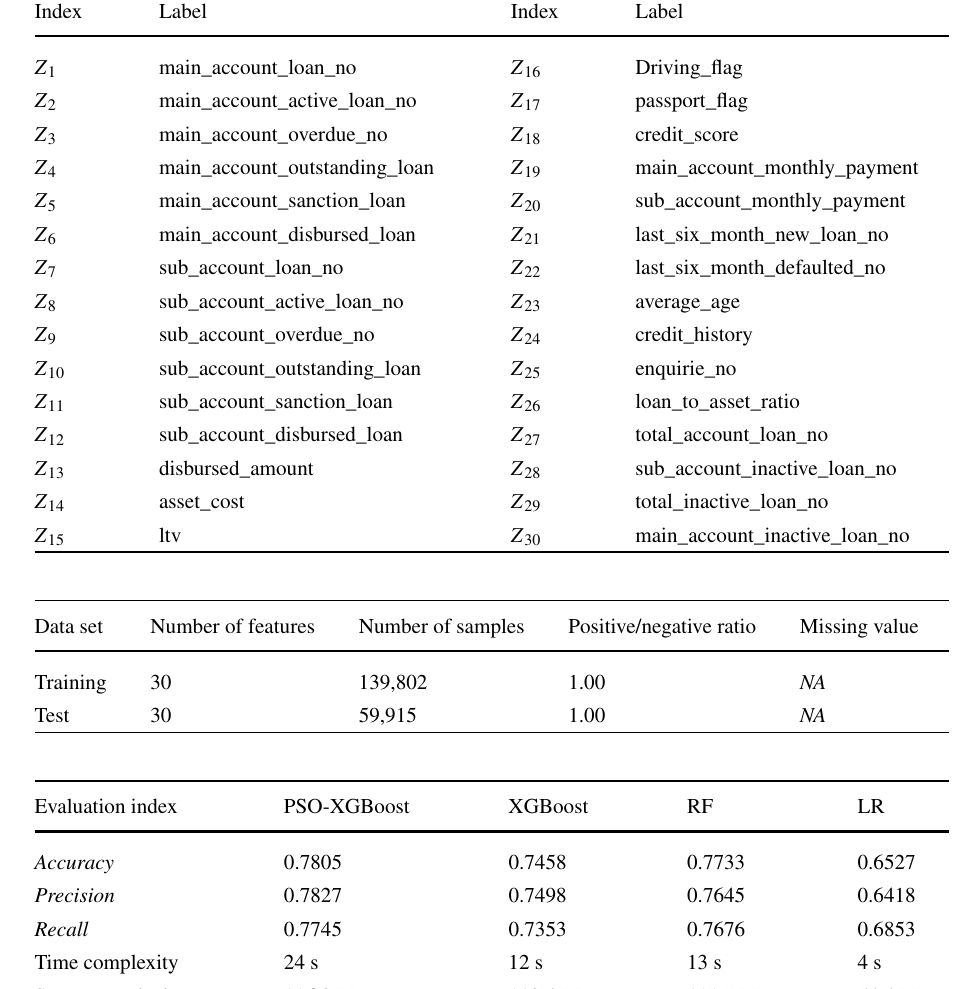
Table 13 The optimal feature subset Index Label